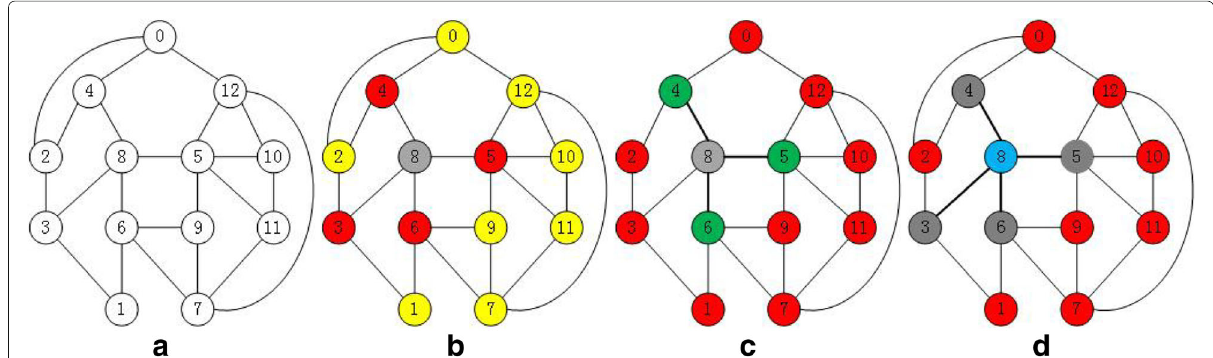
Fig. 2 The process of CDS construction by our algorithm in a – c . d A CDS constructed by algorithm in